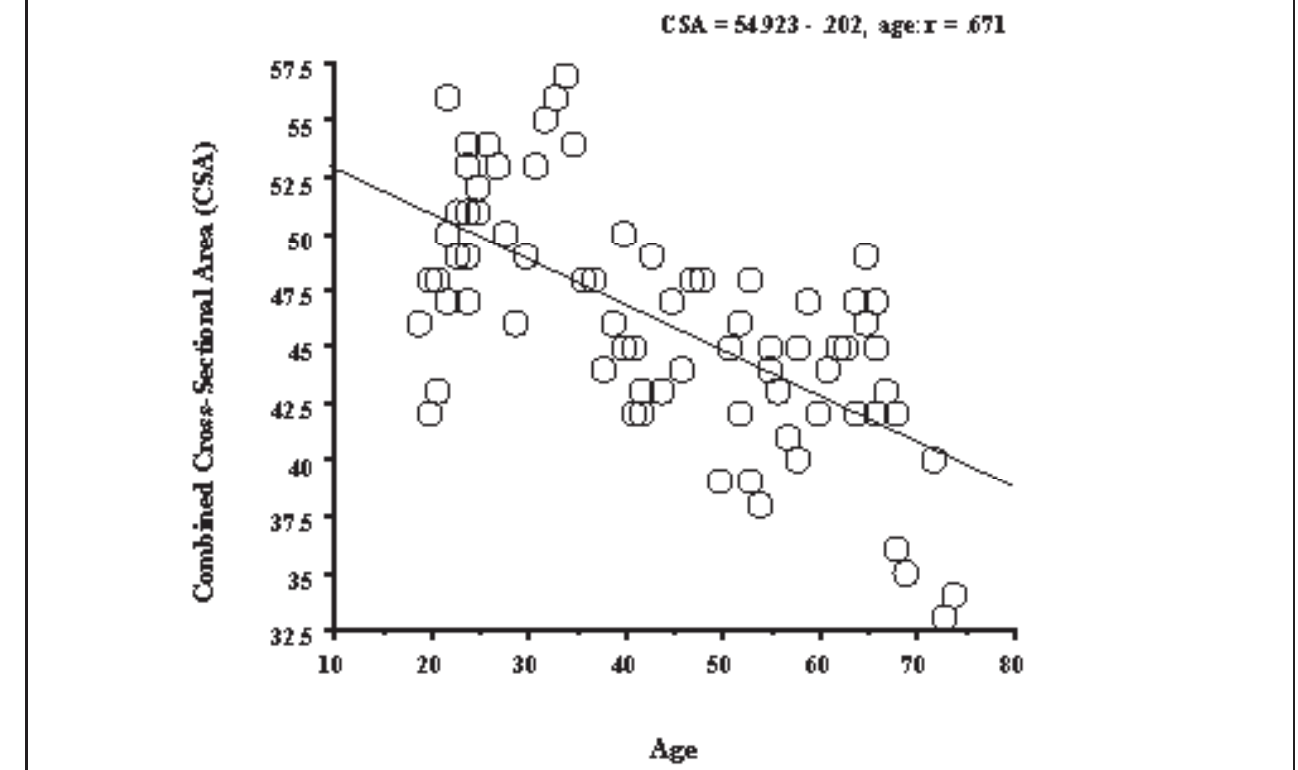
Fig. 3: Significant correlation when comparing between the combined CSA of the ISP and TM and aging r = 0.671, p <0.0001)